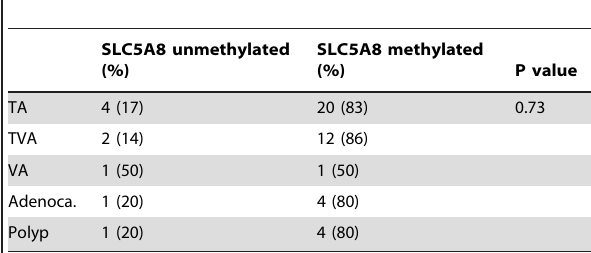
Table 2. SLC5A8 methylation and its relation with the colon adenoma subtype and